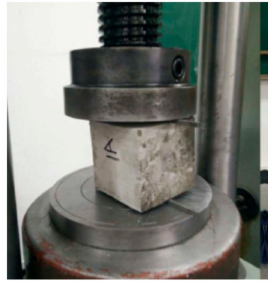
Figure 4. Concrete splitting test.